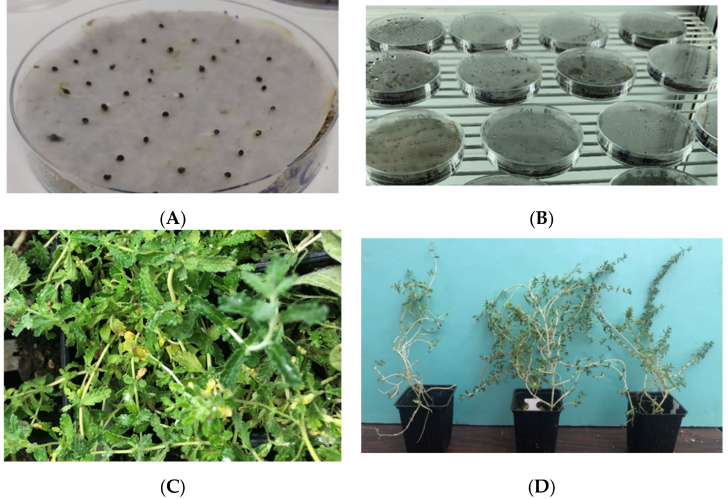
Figure 8. ( A ) Germinated seeds of Teucrium luteum subsp. gabesianum in petri dishes at 20 ◦ C; ( B ) Petri dishes with T. luteum subsp. gabesianum seeds in a growth chamber at 20 ◦ C; ( C ) Morphology of leaves of T. luteum subsp. gabesianum plants; ( D ) Plants of T. luteum subsp. gabesianum at the end of the fertilization experiment: control plant (left), plant with chemical fertilizers (ChF) applied (m ι ddle), and plant with integrated nutrient management fertilizers (INM) applied